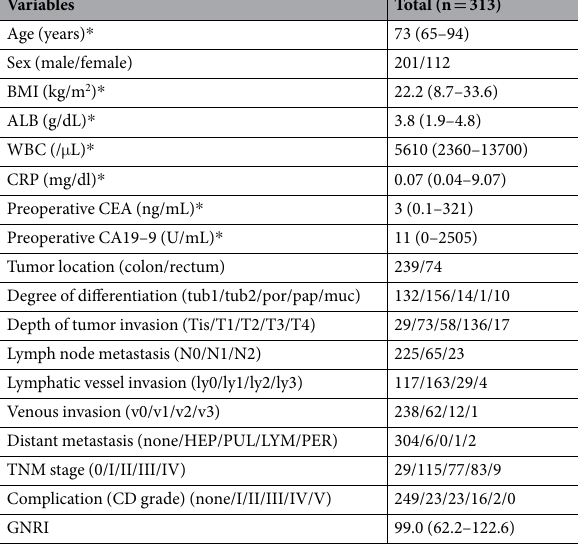
Table 1. The characteristics of 313 patients with CRC. CRC = colorectal cancer, BMI = body mass index, ALB = serum albumin, WBC = white blood cell, CRP = C-reactive protein, CEA = carcinoembryonic antigen, CA19–9 = carbohydrate antigen 19–9, tub1 = well differentiated adenocarcinoma, tub2 = moderately differentiated adenocarcinoma, por = poorly differentiated adenocarcinoma, pap = papillary adenocarcinoma, muc = mucinous adenocarcinoma, HEP = liver, PUL = pulmonary, LYM = extra-regional lymph node, PER = peritoneal, TNM = tumor-node-metastasis, CD = Clavien-Dindo, GNRI = geriatric nutritional risk index, Asterisk values indicate median